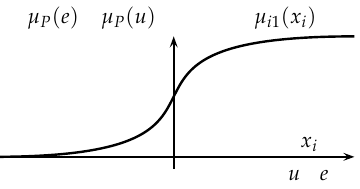
Figure 10. Membership function to model positive values.